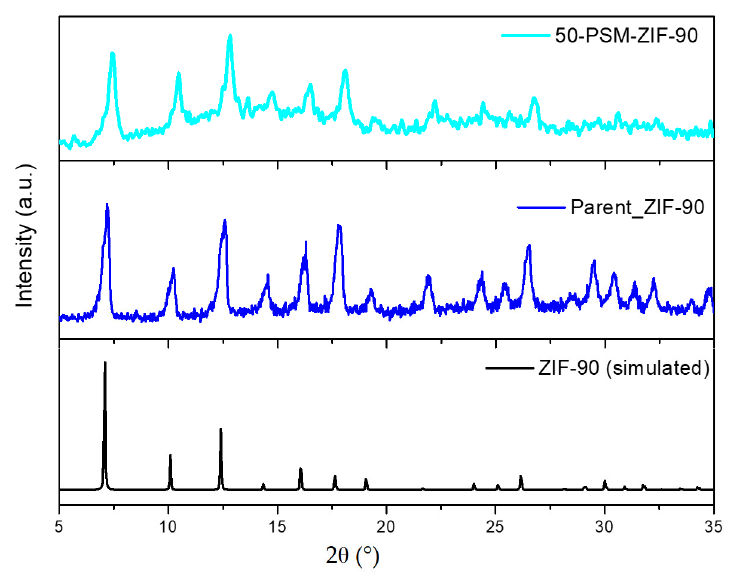
Figure 3. PXRD patterns of the simulated ZIF-90, parent ZIF-90, and 50-PSM-ZIF-90.